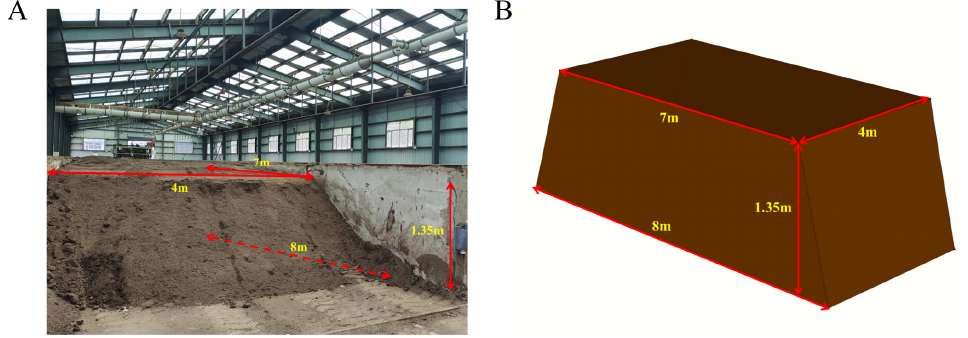
Figure 1. Compost distribution map. (A) compost site photo, (B) compost model.